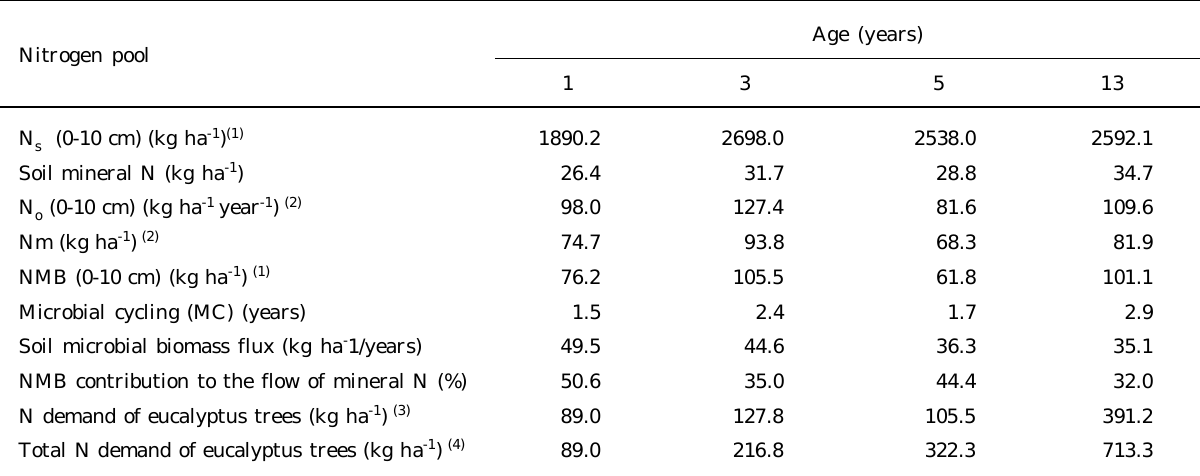
Table 2. Nitrogen pools and microbial nitrogen turnover in the 0-10 cm layer and N demand for eucalyptus in an age